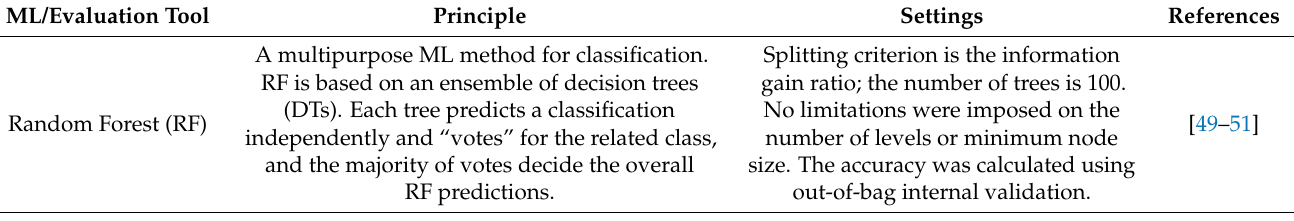
Table 1. List of ML algorithms and evaluation tools that were used in the present